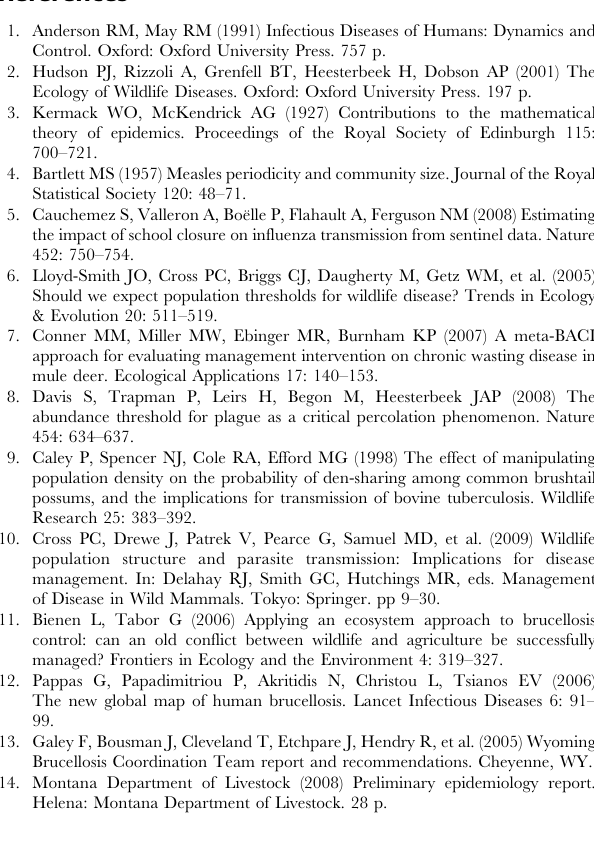
Table S1 Characteristics of the Wyoming hunt areas and herd units used in the analysis. Table S2 Comparison of a priori models using hierarchical Bayesian logistic regressions of 6458 brucellosis test results of adult female Wyoming elk. Figure S1 Map of the most recent elk density estimates from 2004 to 2007. Elk densities were based upon aerial trend counts divided by the area of the unit. Sites labeled with an asterisk did not have any trend count data. Figure S2 Kernel density estimates of the posterior distributions for four parameters in Model 1 (black), and Model 3 (red). b hunt represents the difference between hunter samples and manage- ment captures (A). b fed represents the increased 1991 seropreva- lence associated with supplemental feeding grounds (B). c and h defined the relationship between elk density and the increases in brucellosis over time ( c Density h ; C, D, and E). Note that the scales change among plots. Figure S3 Comparison of model estimates of elk brucellosis prevalence in 1991 (lower half) and 2009 (upper half) using models 1, 2, 3, 7 and 8 (Table 1). The dashed line is a 45 degree line representing an exact correspondence among model estimates.